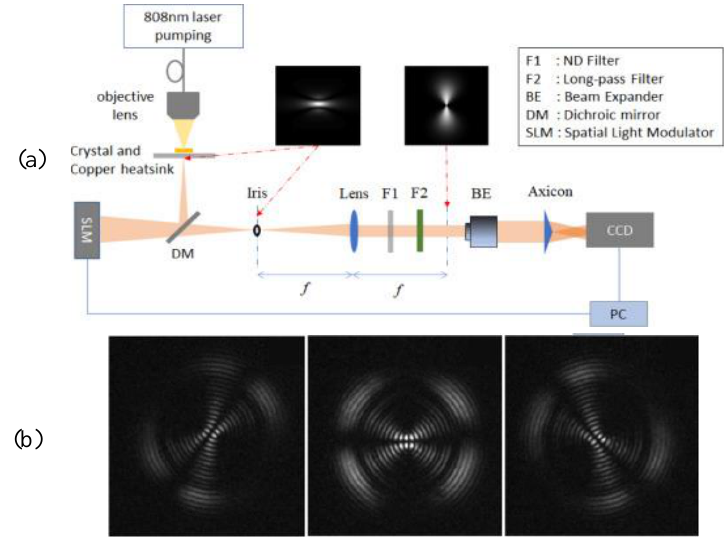
Figure 9. ( a ) Schematic of the L-type digital lasers setup; ( b ) Quasi-Mathieu beams with different angles of 44°, 92°, and 136°, respectively (Adapted from an open-access source Ref. [80]) .